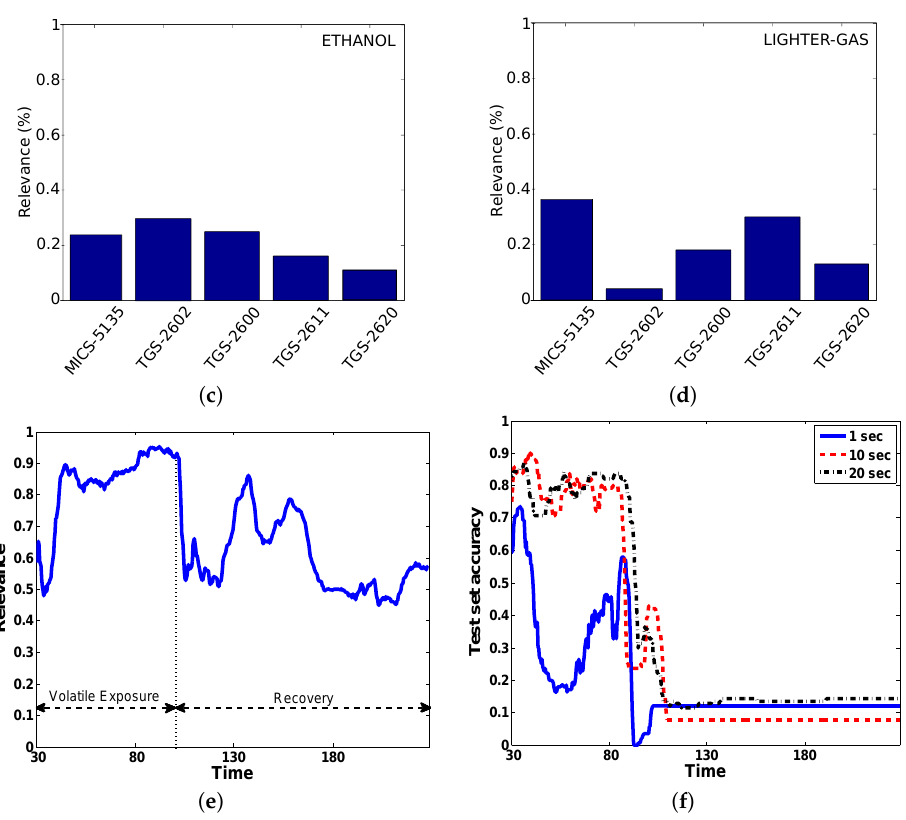
Figure 3. Illustration of the sensor and time points relevance for the classification of gases: ( a – d ) normalized sensor relevance of an e-nose composed of five gas sensors when exposed to four different gas classes; ( e ) time points relevance profile averaged over all classes; and ( f ) mean prediction accuracy over time for window lengths of ≈ { 1,10 and 20 } s. These results correspond to an e-nose dataset collected under semi-controlled measurement conditions as described in [34].